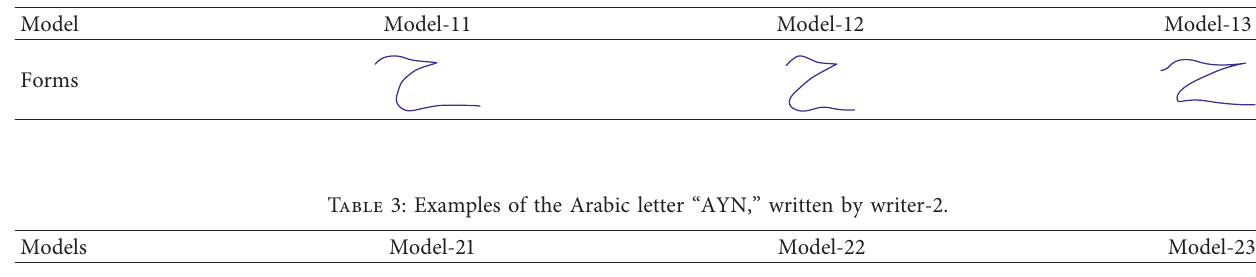
Table 2: Examples of the Arabic letter “HA,” written by writer-1.